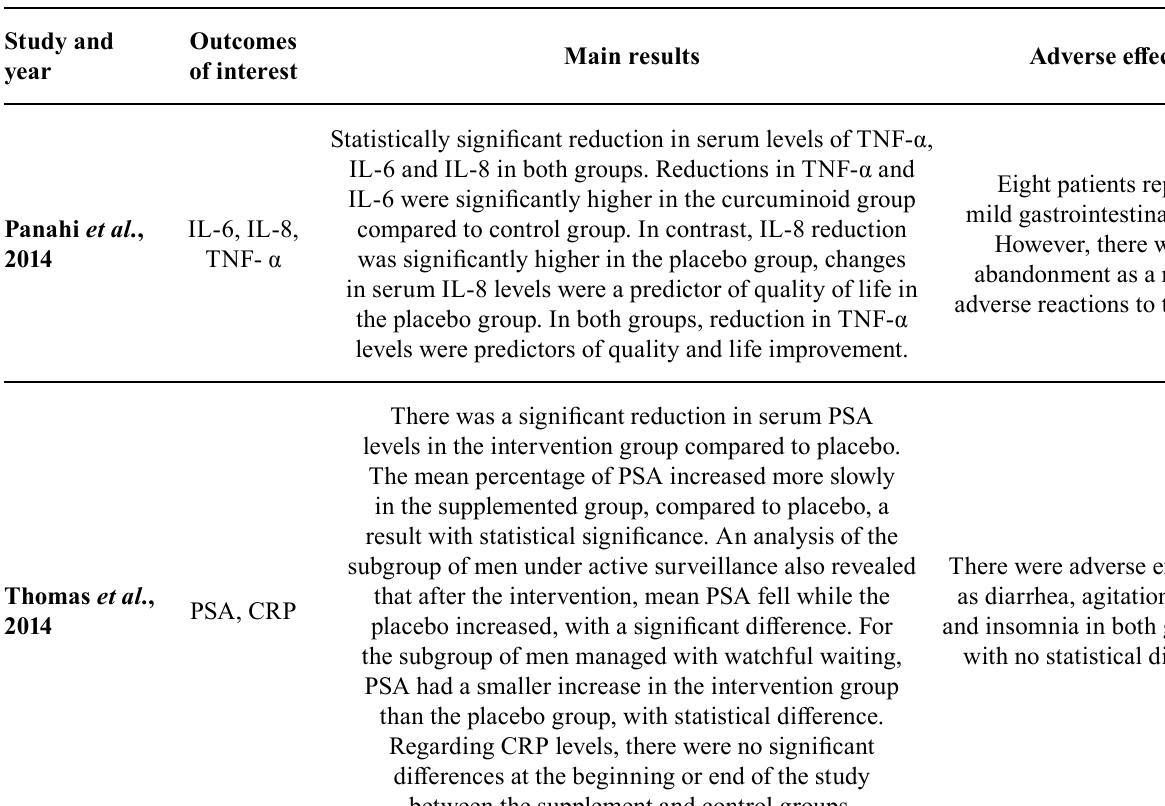
TABLE II – Summary of main results of clinical